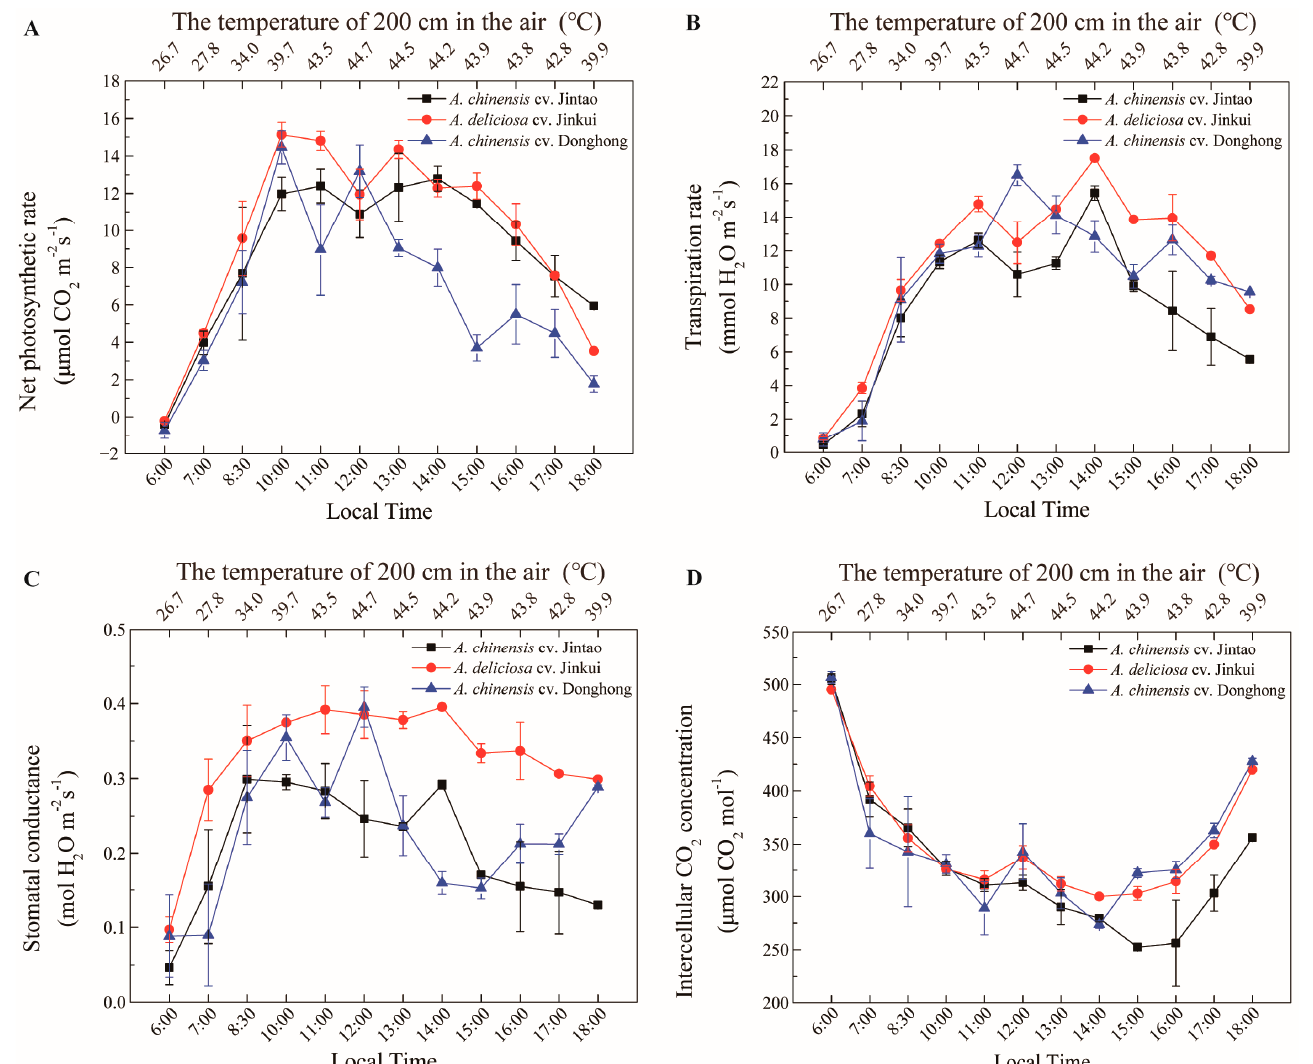
Figure 5. Net photosynthetic rate ( A ) ( μ mol CO 2 m − 2 s − 1 ), transpiration rate ( B ) (mmol H 2 O m − 2 s − 1 ), stomatal conductance ( C ) (mol H 2 O m − 2 s − 1 ) and intercellular CO 2 concentration ( D ) ( μ mol CO 2 mol − 1 ) changes of diploid, tetraploid and hexaploid kiwifruit cultivars at high temperatures.